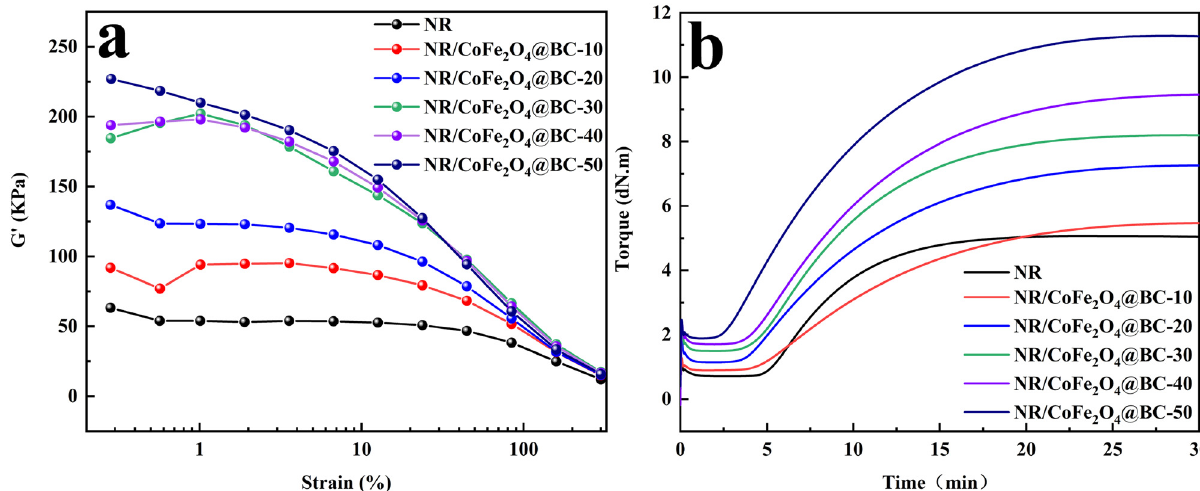
Figure 4: ( a ) Nonlinear dynamic and ( b ) curing curves of NR composite with di ff erent CoFe 2 O 4 @BC loadings.